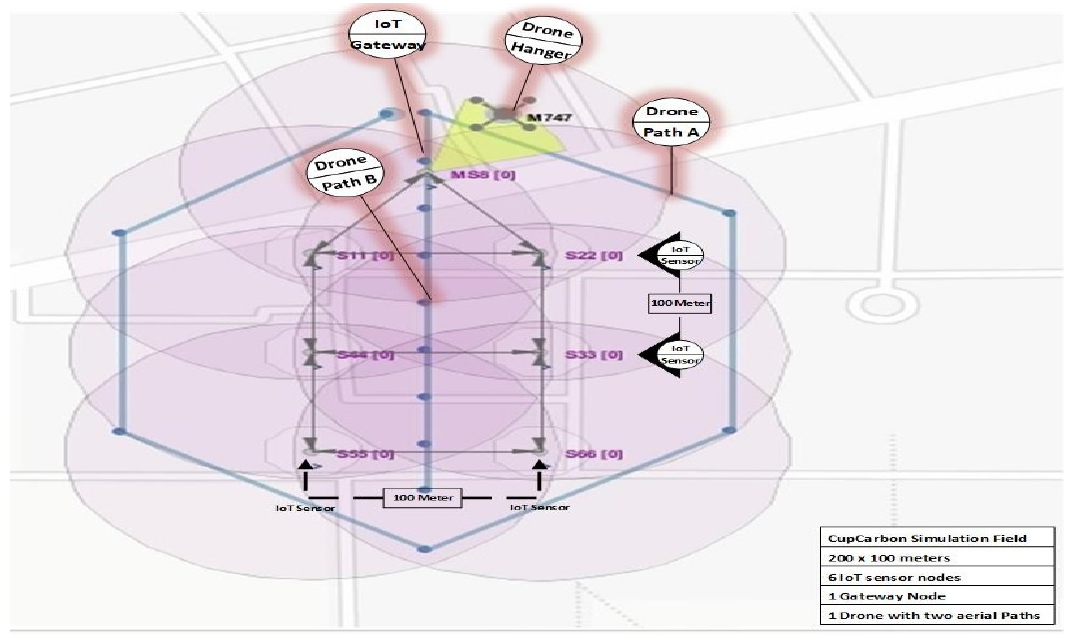
Figure 6. Proposed IoT network with IoT sensors with gateway and drone deployment.